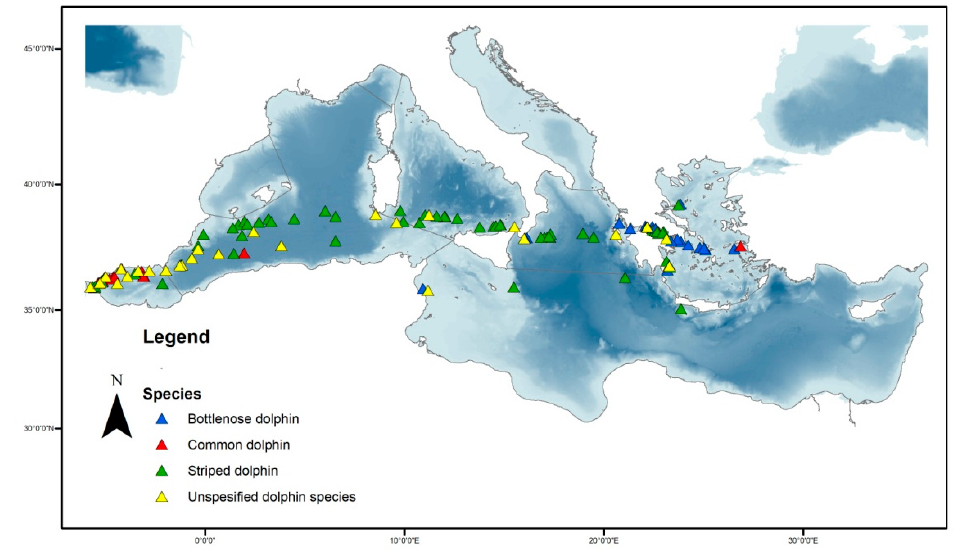
Figure2. Distributionofvisualmammalclustersobservations. Eachspeciesisshownbyadi ff Figure 2. Distribution of visual mammal clusters observations. Each species is shown by a different color.